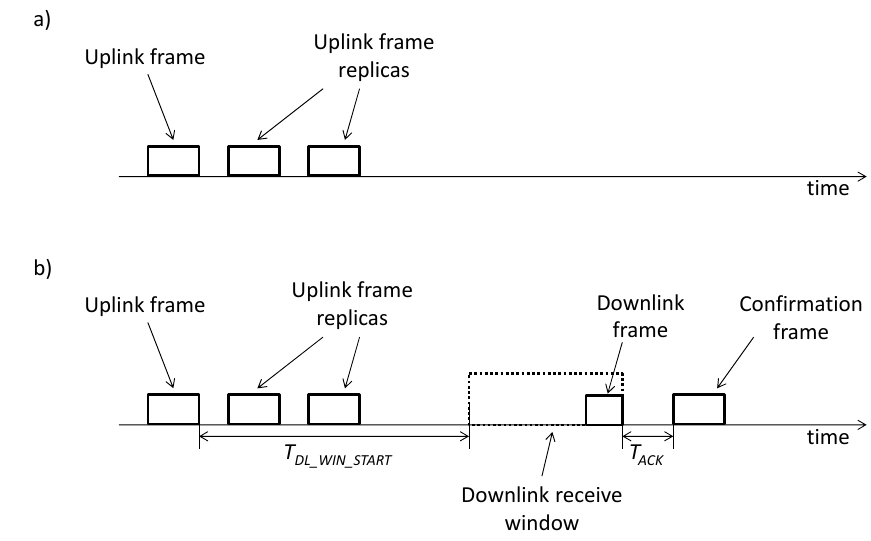
Figure 3. ( a ) Unidirectional and ( b ) bidirectional transactions in Sigfox.